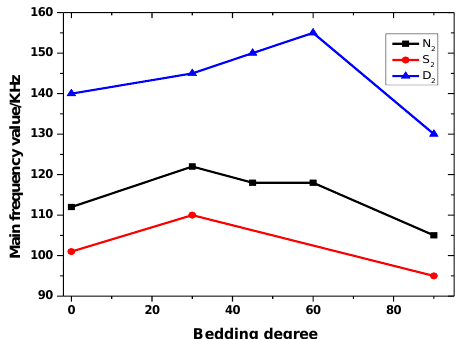
Figure 15. Curves of final main frequency value with different bedding angles under different water content levels.